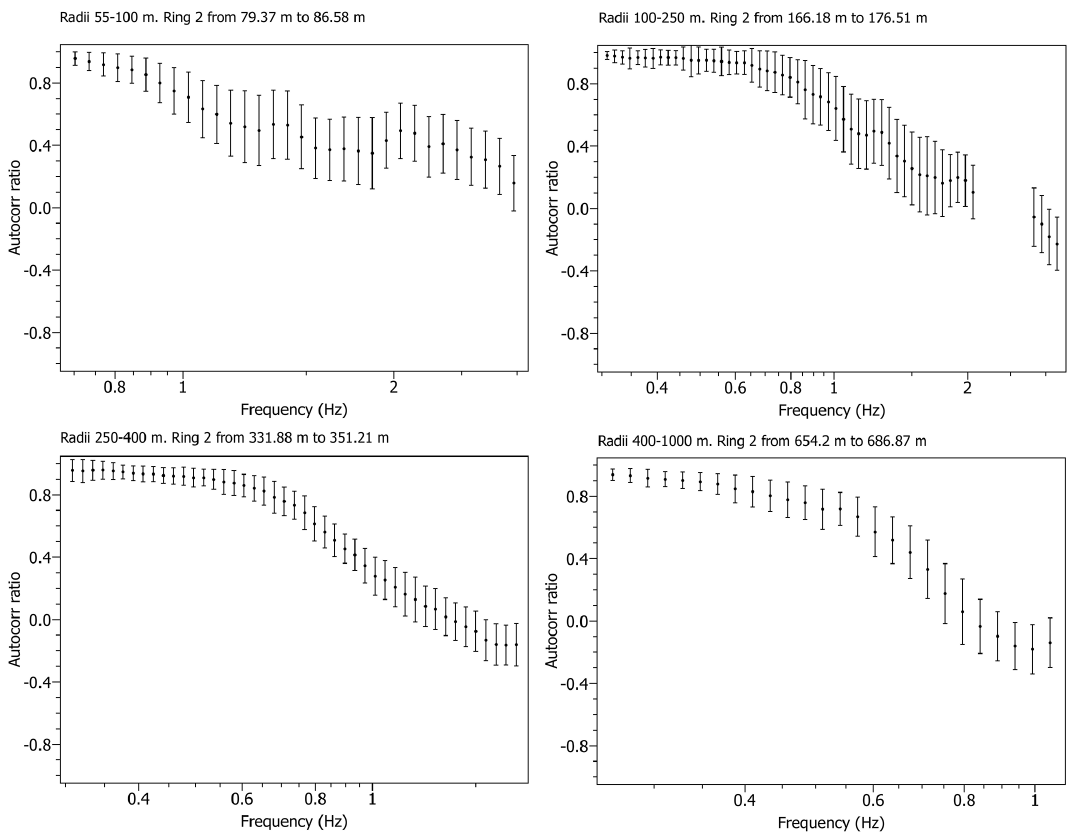
Figure 5. SPAC analysis. Autocorrelation curves (grey dots with error bars) obtained for array 1 at each